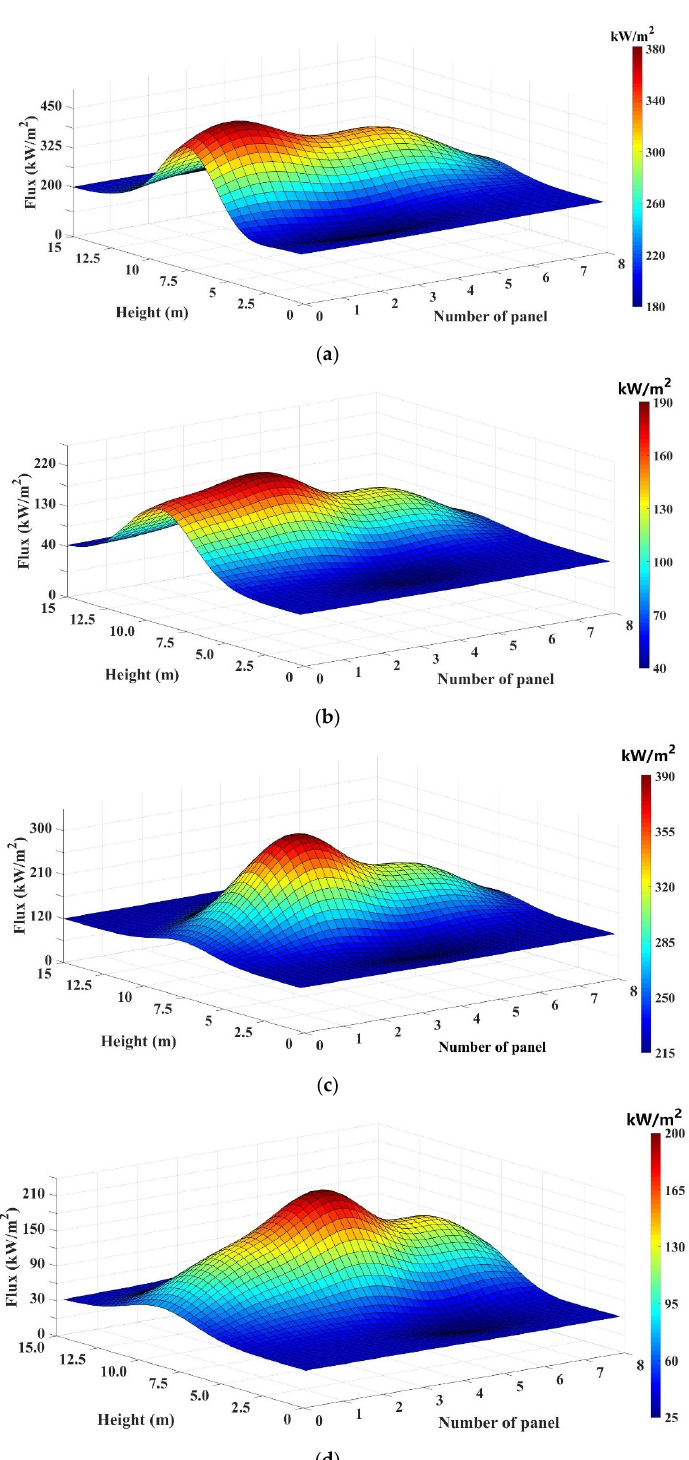
Figure 5. Energy flux distribution on the surface of the receiver at each typical moment: ( a ) energy flux distribution at 12:00; ( b ) energy flux distribution at 14:00; ( c ) energy flux distribution at 16:00; ( d ) energy flux distribution at 18:00.